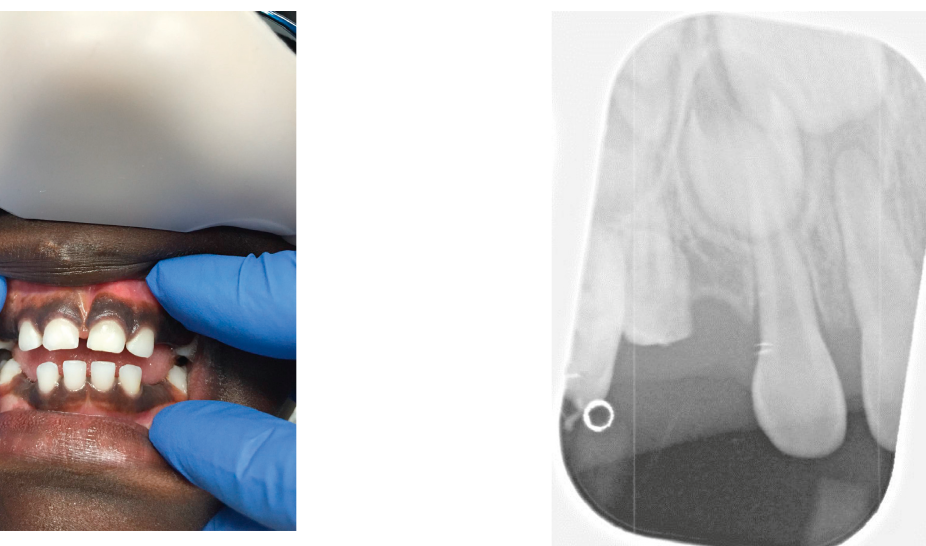
Figure 1: An intraoral photo of the 4-year-old male patient shows the missing maxillary and mandibular right and left primary canines.